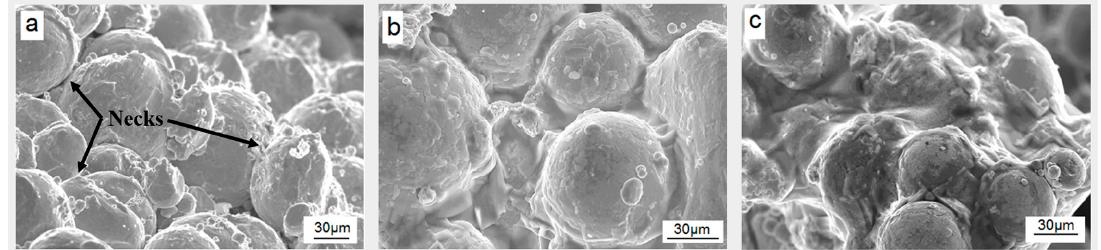
Figure 1. Typical SEM images of samples after ( a ) green compaction (50 kN) and sintering at 1000 °C followed by water quenching; ( b ) hot-pressing at 600 °C with 50 kN; and ( c ) hot-pressing at 600 °C with 50 kN followed by sintering at 1000 °C and water quenching.